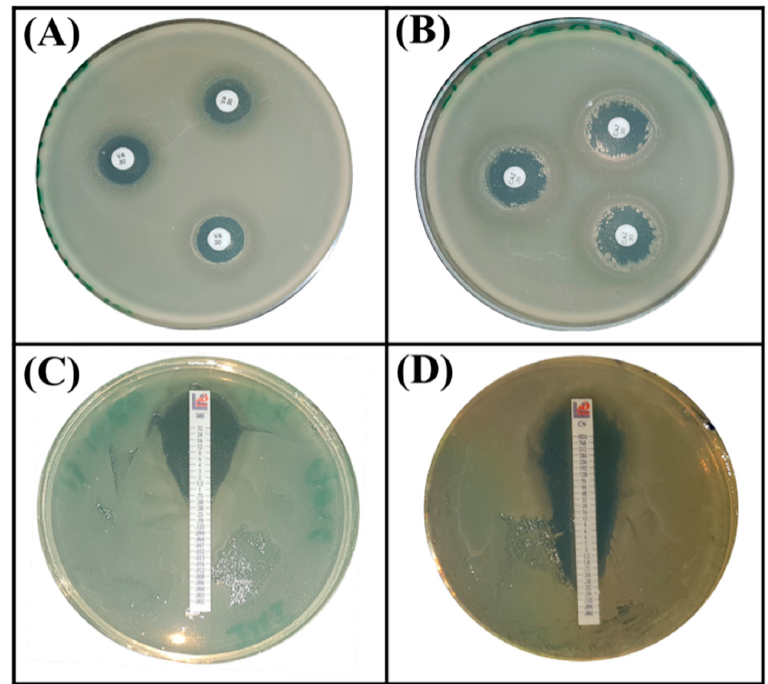
Figure 6. Antibiotic resistance assays using Serratia rubidaea ED1 strain on MHA (Mueller Hinton Agar, BIOKAR Diagnostics, BEAUVAIS, France) plates supplemented by antibiotic disc method ( A , B ) and Etest ( C , D ). (A) vancomycin, ( B ) ceftazidime, ( C ) imipenem, ( D ) gentamycin. Table 4. Antibiotic resistance profile of the S. rubidaea ED1 strain using disc diffusion, Etest, and antibiotic amended agar methods.